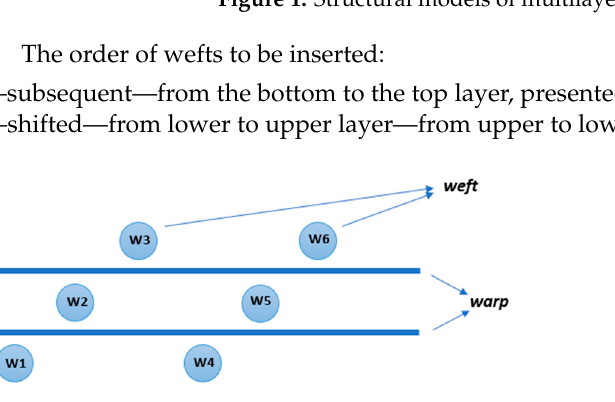
Figure 2. Subsequent model of wert insertion.